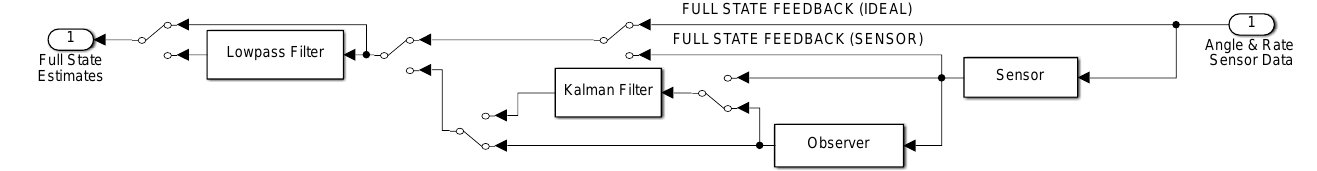
Figure A6. Sensors and Observers block model.